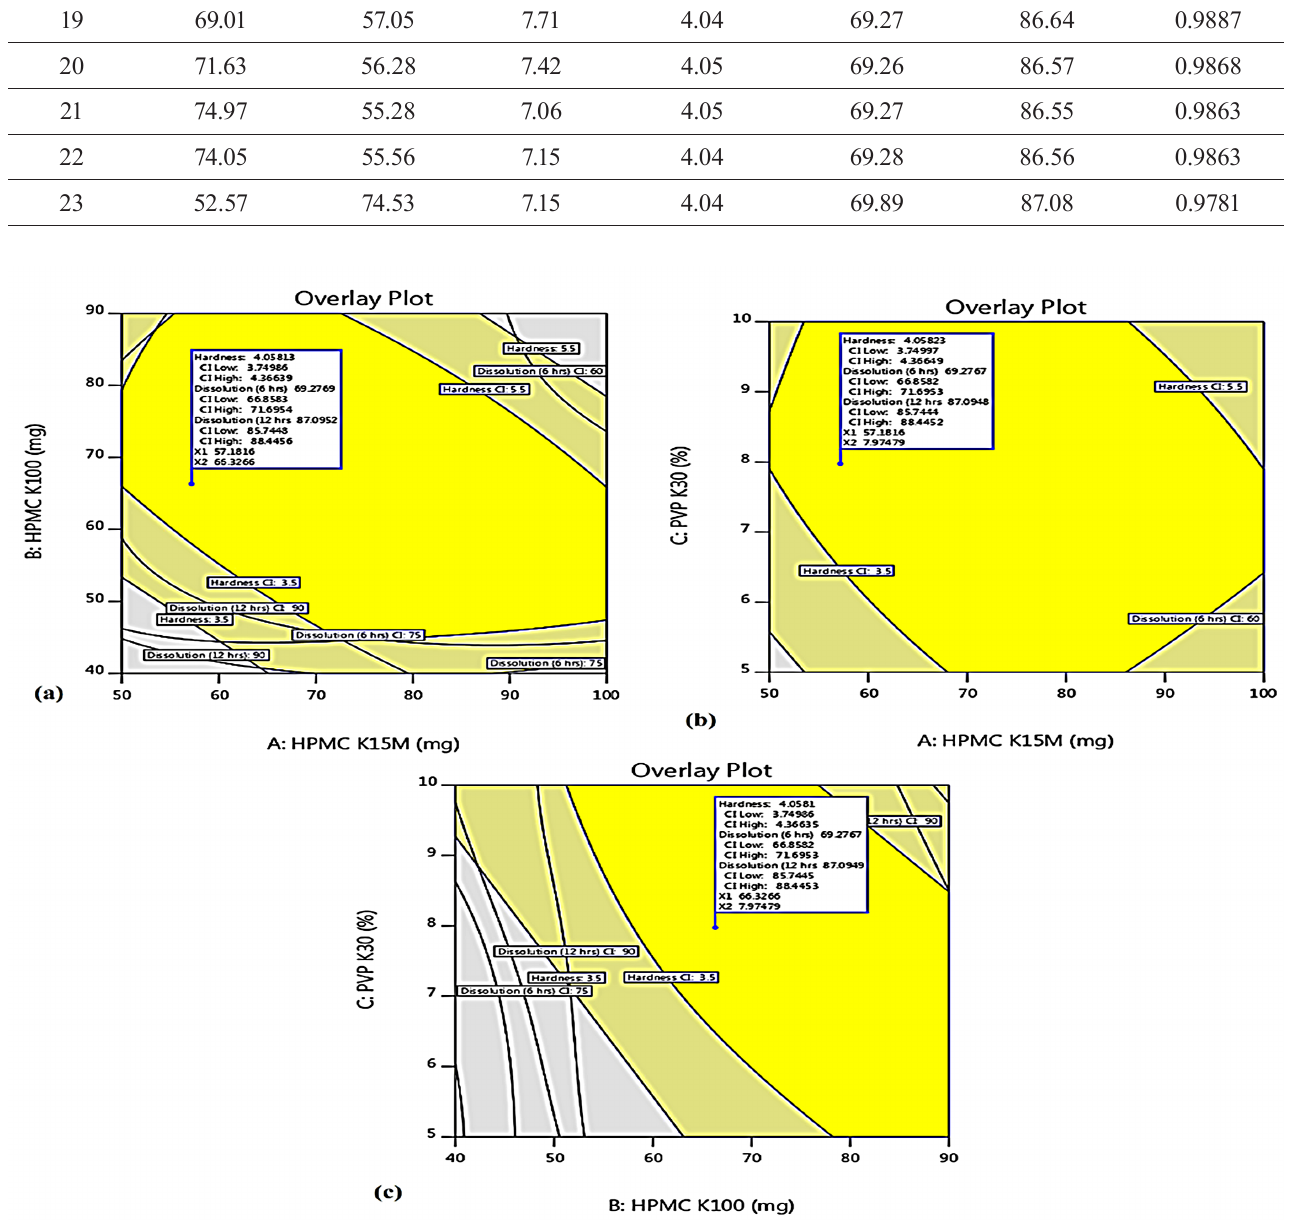
FIGURE 7 - Overlay plot for finding the optimizing region as per predetermined set value for (a) Hardness, (b) Dissolution (6 h) (c) Dissolution (12